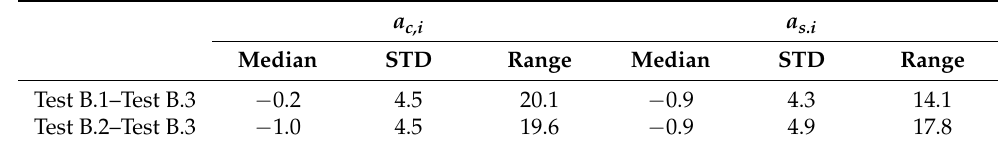
Table 7. Test B: statistics of the differences in the corrections (units: µ as). a c,i a